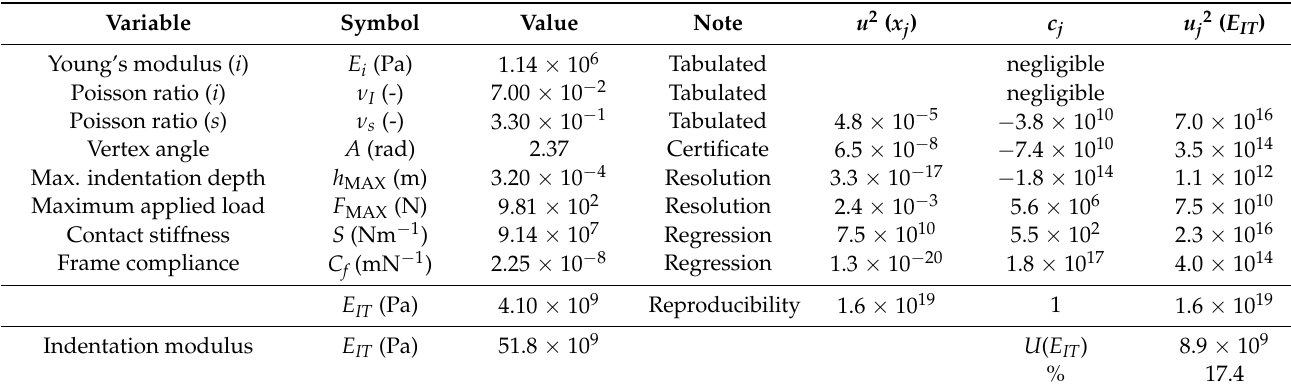
Table 6. Uncertainties for indentation modulus E IT of copper alloy for